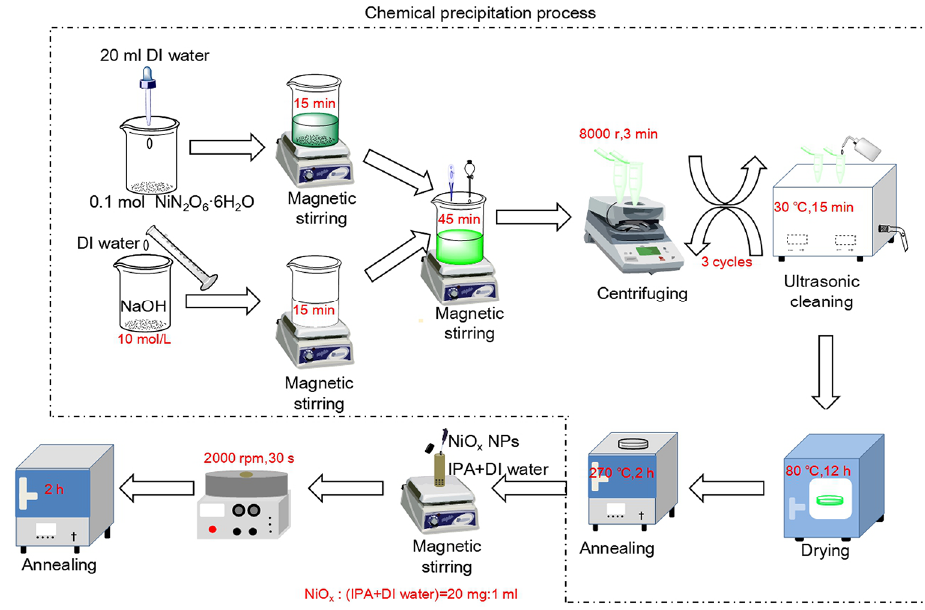
Figure 1. Preparation flowchart of NiO x NPs and NiO x films.